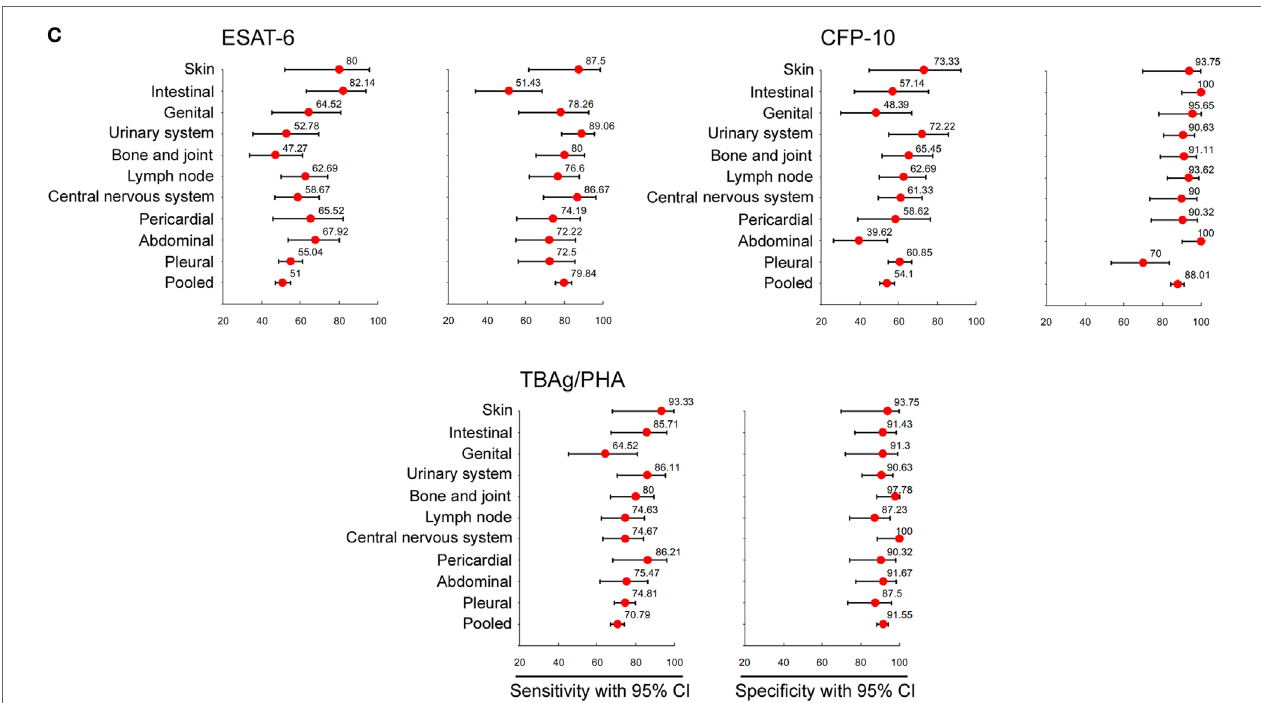
FigUre 1 | T-SPOT results and the TBAg/PHA ratio in distinguishing EPTB from non-EPTB. (a) Dot plots showing ESAT-6 sfc, CFP-10 sfc, and the TBAg/PHA ratio in T-SPOT positive patients with different types of EPTB ( n = 647) and non-EPTB ( n = 367). Bars indicate medians (* p < 0.05, ** p < 0.01, and *** p < 0.001). (B) Receiver operating characteristic analysis was performed for ESAT-6 sfc, CFP-10 sfc, and the TBAg/PHA ratio to determine threshold values for discriminating between EPTB and non-EPTB. (c) Forest plots showing the optimal sensitivity and specificity of ESAT-6 sfc, CFP-10 sfc, and the TBAg/PHA ratio in distinguishing EPTB from non-EPTB. Abbreviations: EPTB, extrapulmonary tuberculosis; ESAT-6, early secreted antigenic target 6; CFP-10, culture filtrate protein 10; AUC, area under the curve; CI, confidence intervals; TBAg, TB-specific antigen; PHA, phytohemagglutinin; sfc, spot-forming cells.